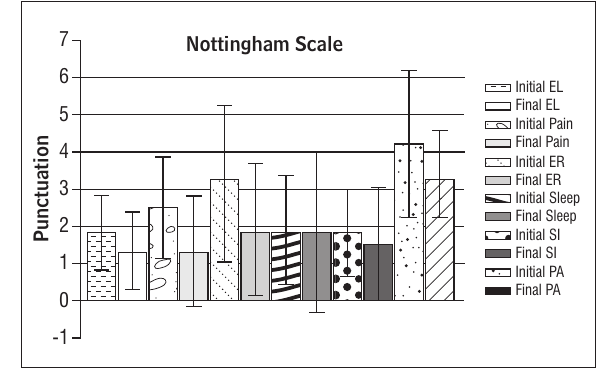
Figure 3 - Nottingham